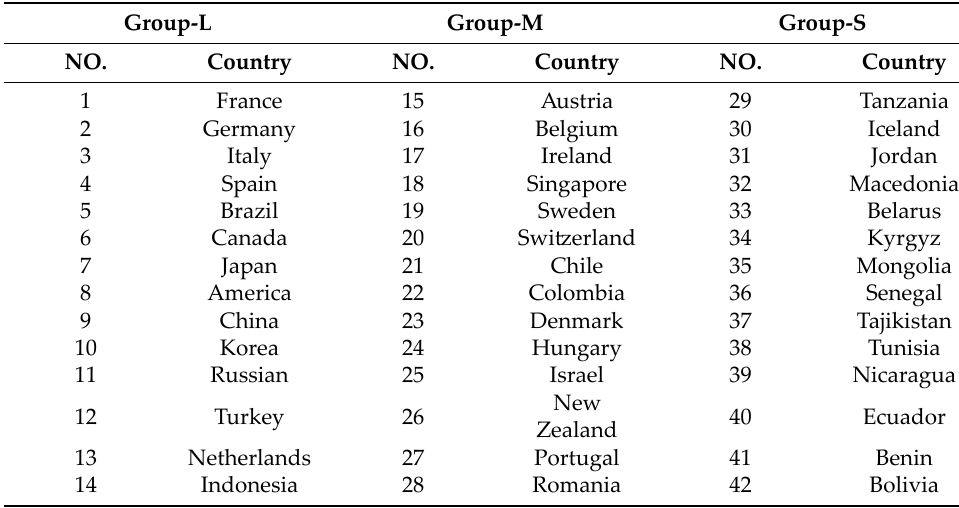
Table A1. Representative 42 sample countries and their